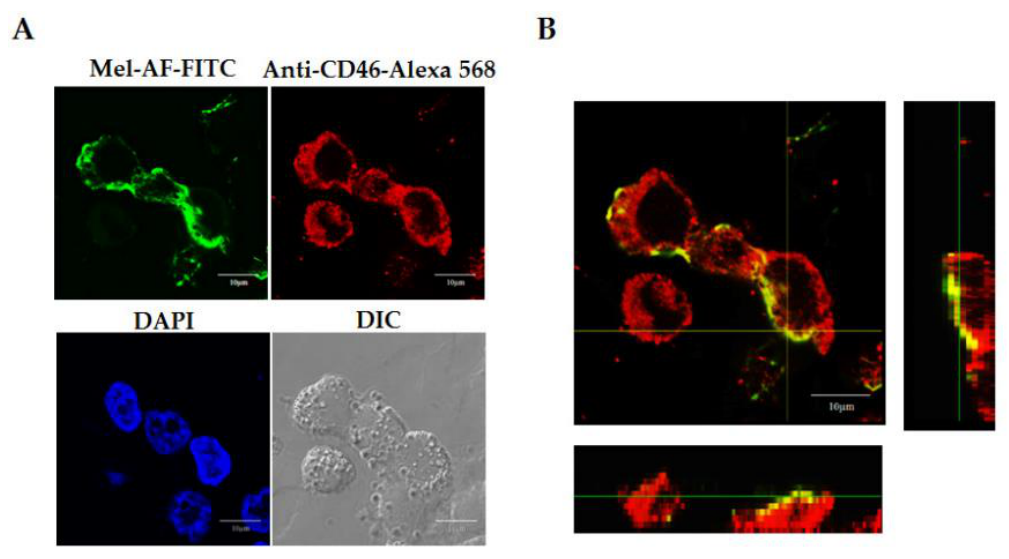
Figure 3. Localization of Mel-AF on A375 cells was analyzed using a confocal laser scanning microscope. The cells were treated with FITC-conjugated Mel-AF for 2 h. ( A ) Confocal images show the localization of Mel-AF traced with FITC (green). The membrane compartment was indicated by staining with a specific antibody to CD46, a membrane cofactor protein followed by Alexa Fluor 568 rabbit anti-mouse IgG (red). The cellular nuclei were counterstained by DAPI (blue). ( B ) Orthogonal imaging analysis was performed to confirm the localization of Mel-AF on the cell membrane (yellow). Scale bar, 10 μ m.